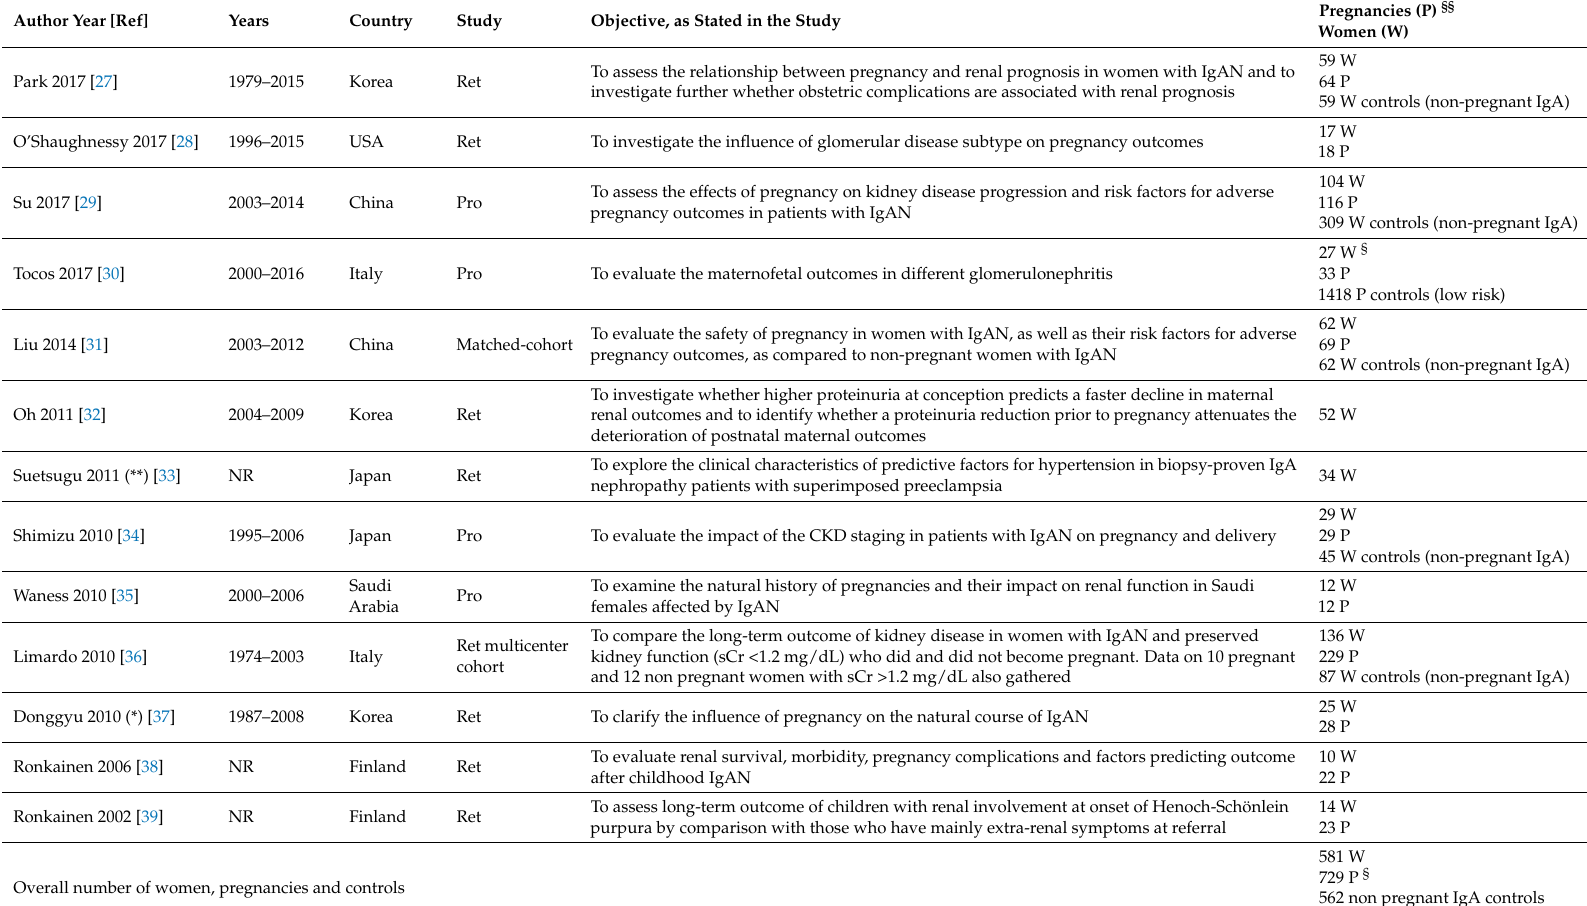
Table 1. IgA nephropathy: Main characteristics of the case series (at least 6